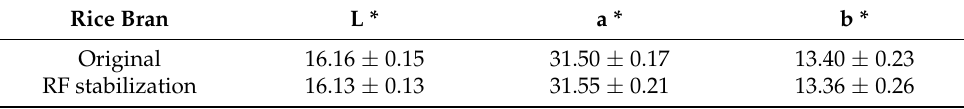
Table 3. Color analyses of the RF-stabilized rice